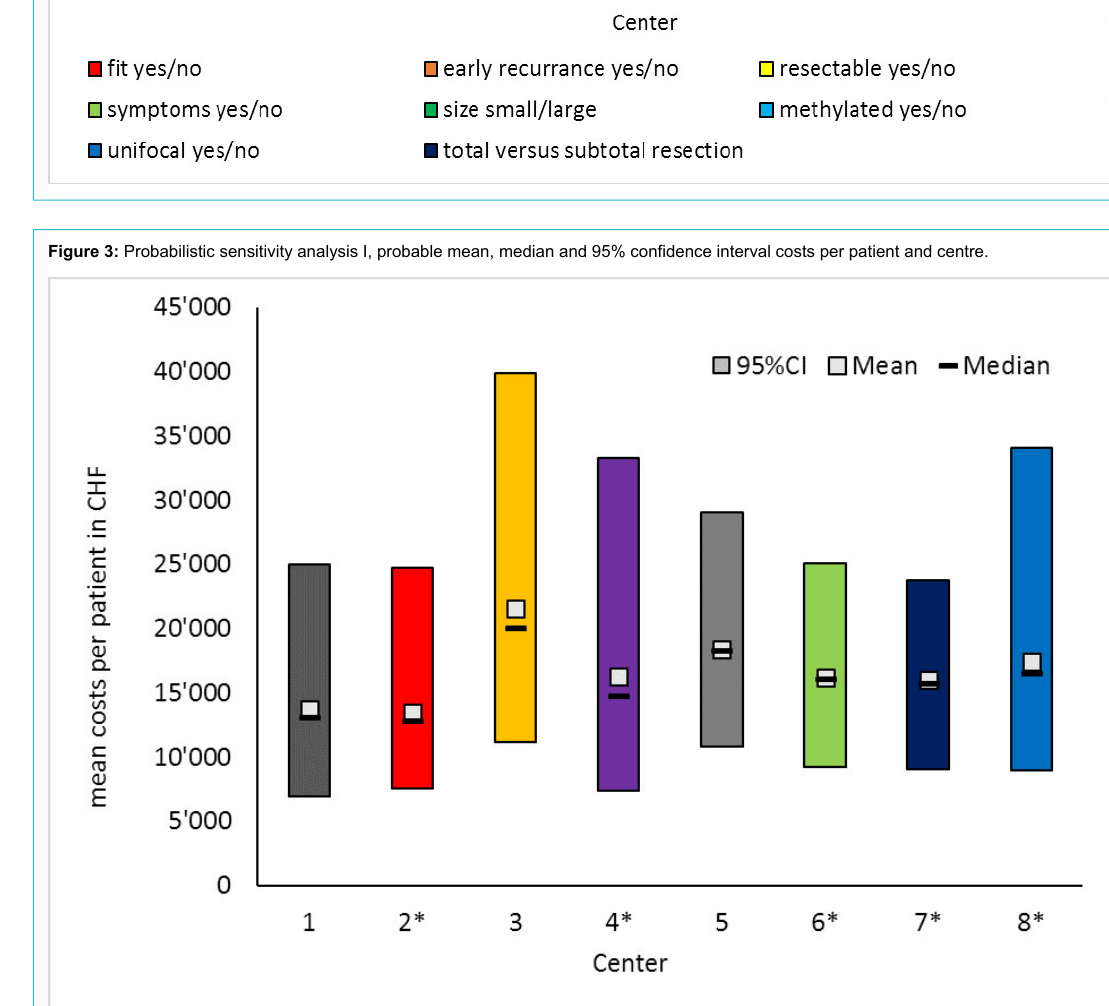
Figure 3: Probabilistic sensitivity analysis I, probable mean, median and 95% confidence interval costs per patient and